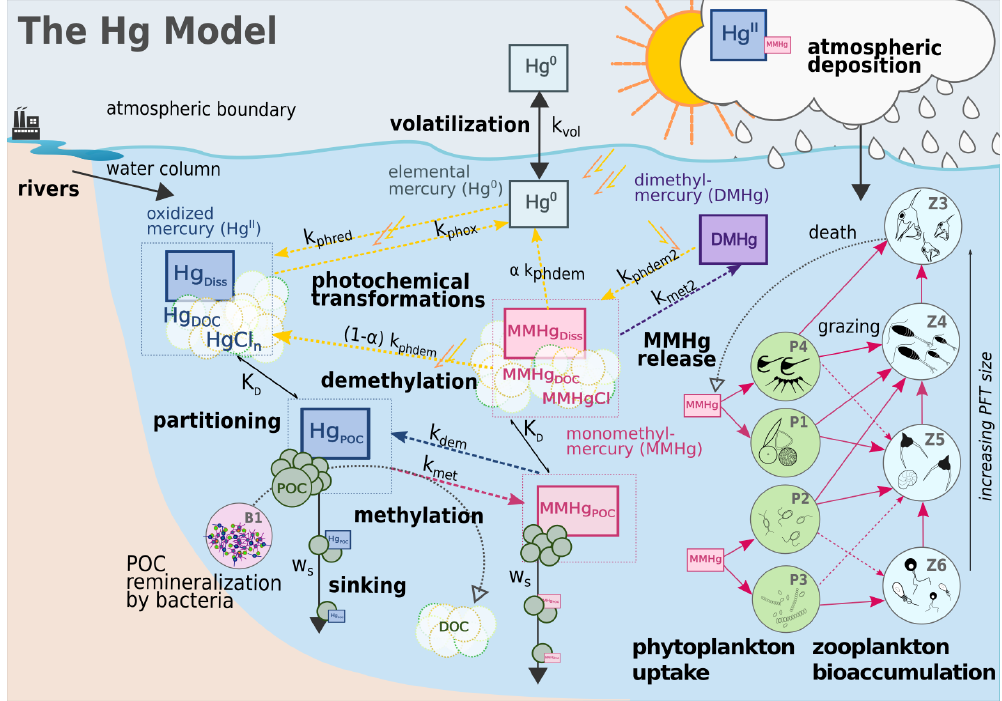
Figure 3. Hg dynamics in the coupled model OGSTM–BFM–Hg. The Hg model simulates the cycling of inorganic (Hg II and Hg 0 ) and methylated (MMHg and DMHg) Hg species resolving the partitioning of Hg II and MMHg between particulate (Hg POC , MMHg POC ) and dissolved species (Hg Diss , as Hg DOC + HgCln, and MMHg Diss , as MMHg DOC + MMHgCl) based on partition coefficients ( K D ) and con- centrations of POC and DOC, the photochemical and biological transformations (dotted colored arrows) as first-order kinetics depending on the rate constants k x , the evasion of Hg 0 to the atmosphere controlled by wind speed through the volatilization rate constant k vol , and the MMHg bioaccumulation (pink arrows) driven by phytoplankton uptake in four different PFTs and trophic transfer to four zooplankton